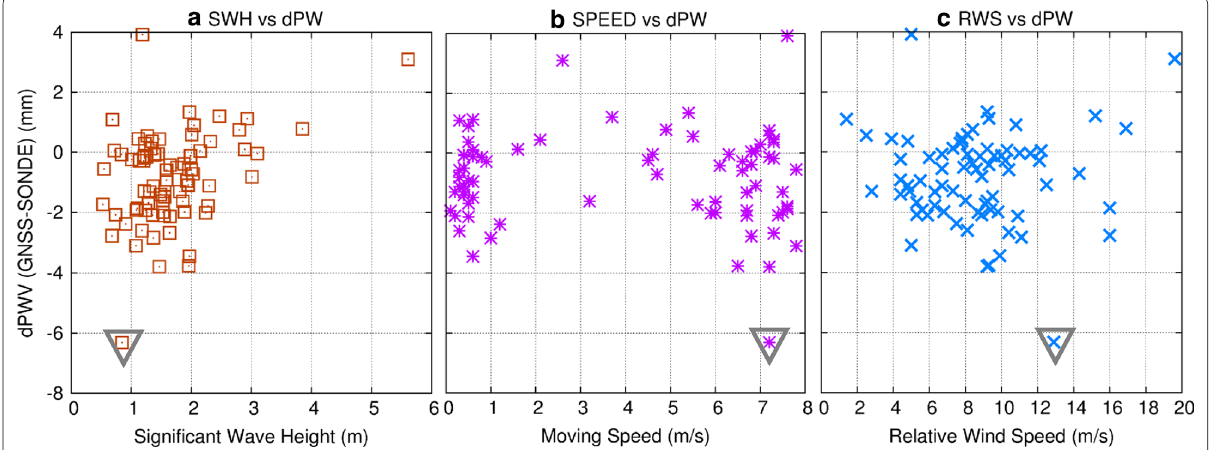
Fig. 12 Scatter plots of the differences in the GNSS PWV versus the radiosonde observations and a significant wave height, b vessel moving speed, and c relative wind speed. Plots with gray inverted triangles are comparisons with the radiosonde launched at 2331 UTC on June 10,